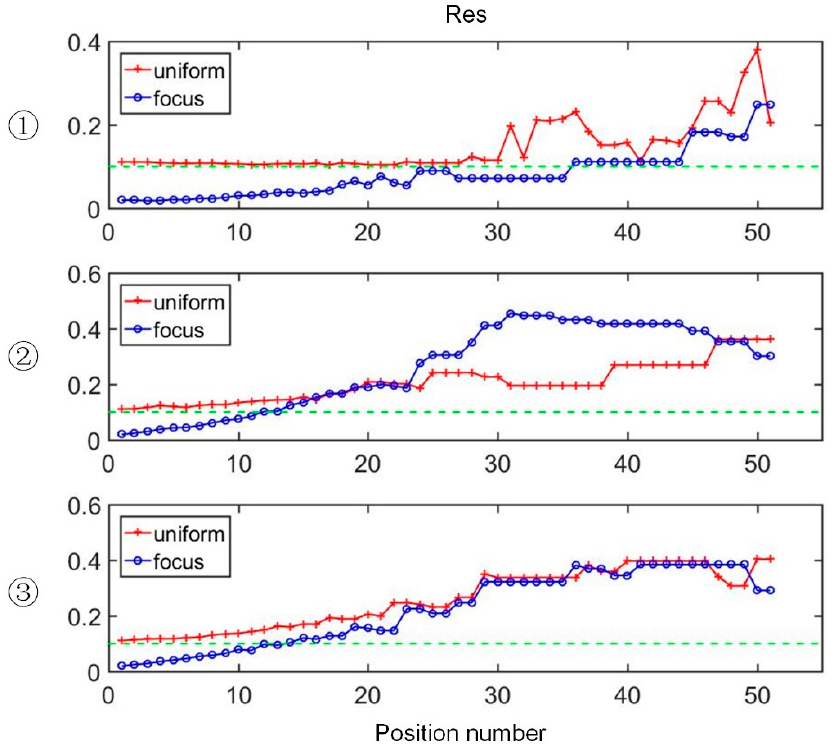
Figure 9. The evolutions of minimum RES with respect to the inclusion positions: ① , ② and ③ denotes the evaluations at Direction 1, 2 and 3, respectively.